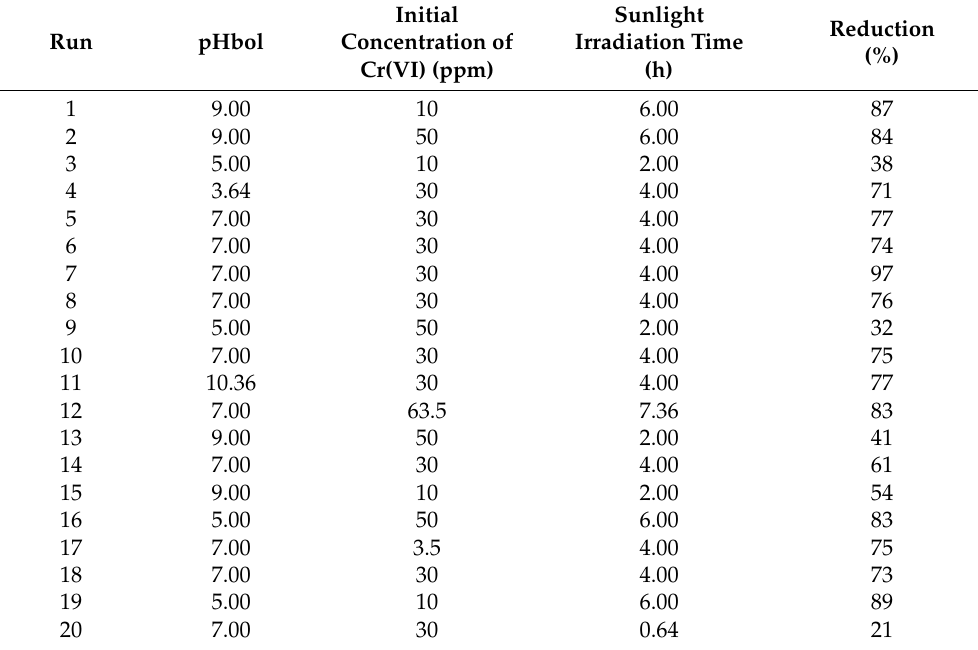
Table 1. Experimental results of solar photocatalytic reduction of Cr(VI) for runs provided by cen- tral composite design.